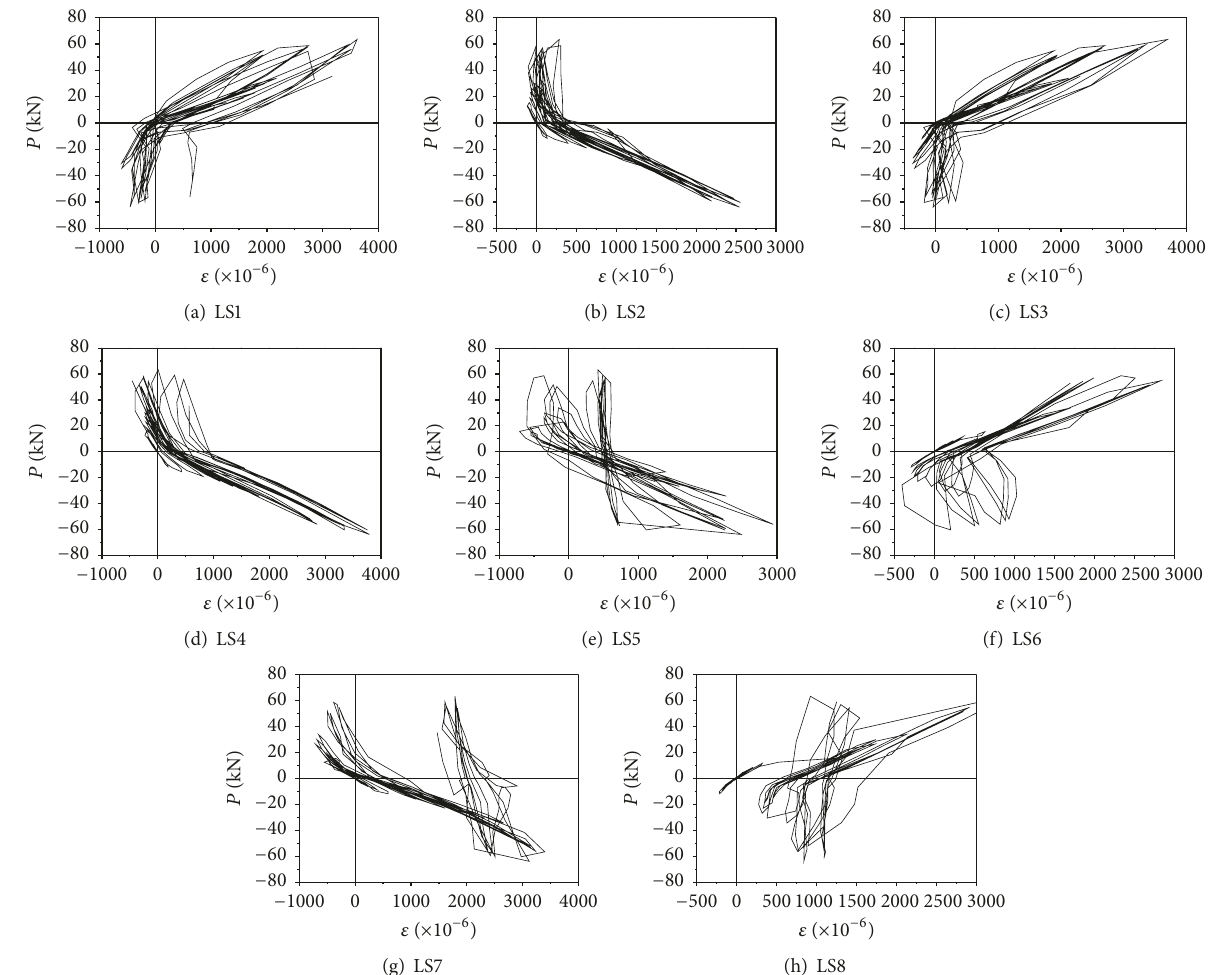
Figure 6: Load-strain hysteresis curve of specimen ZJ2 longitudinal steel